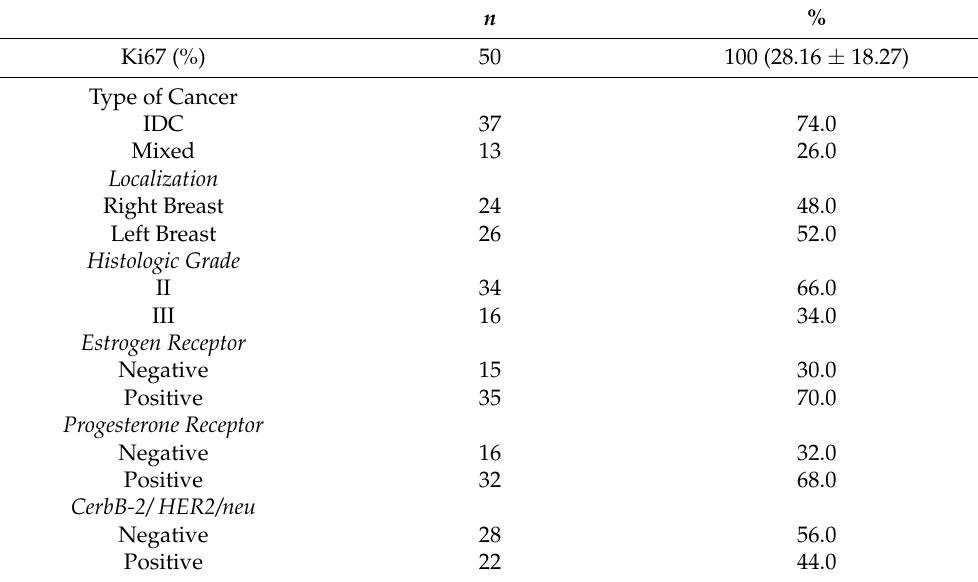
Table 2. Clinicopathological features of breast cancer